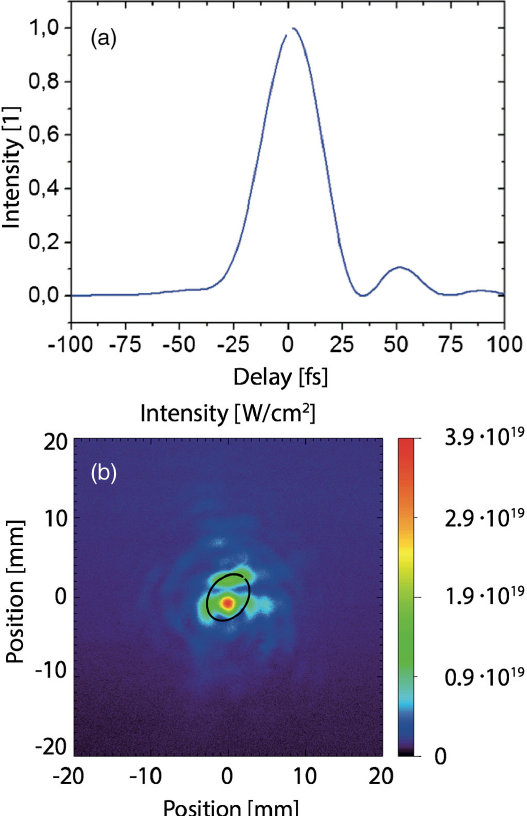
FIG. 1. Temporal pulse (a) shape and intensity distribution (b) (color coded, and marked area for determination of encircled energy content) used in experiments (example of laser probe